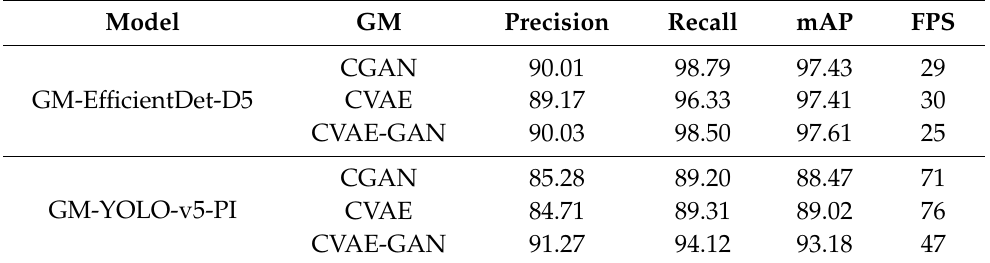
Table 6. Performance of different generative module implementation on different models.